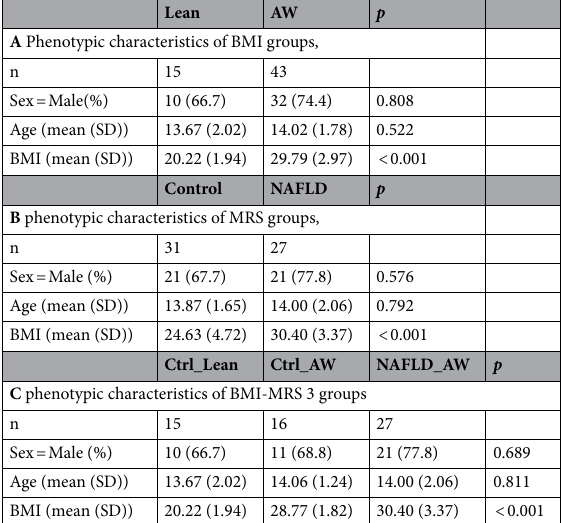
Table 1. Phenotypic characteristics of BMI groups, MRS groups, and BMI-MRS 3 groups. The BMI between the Ctrl_AW and NAFLD_AW (wilcox test, P =